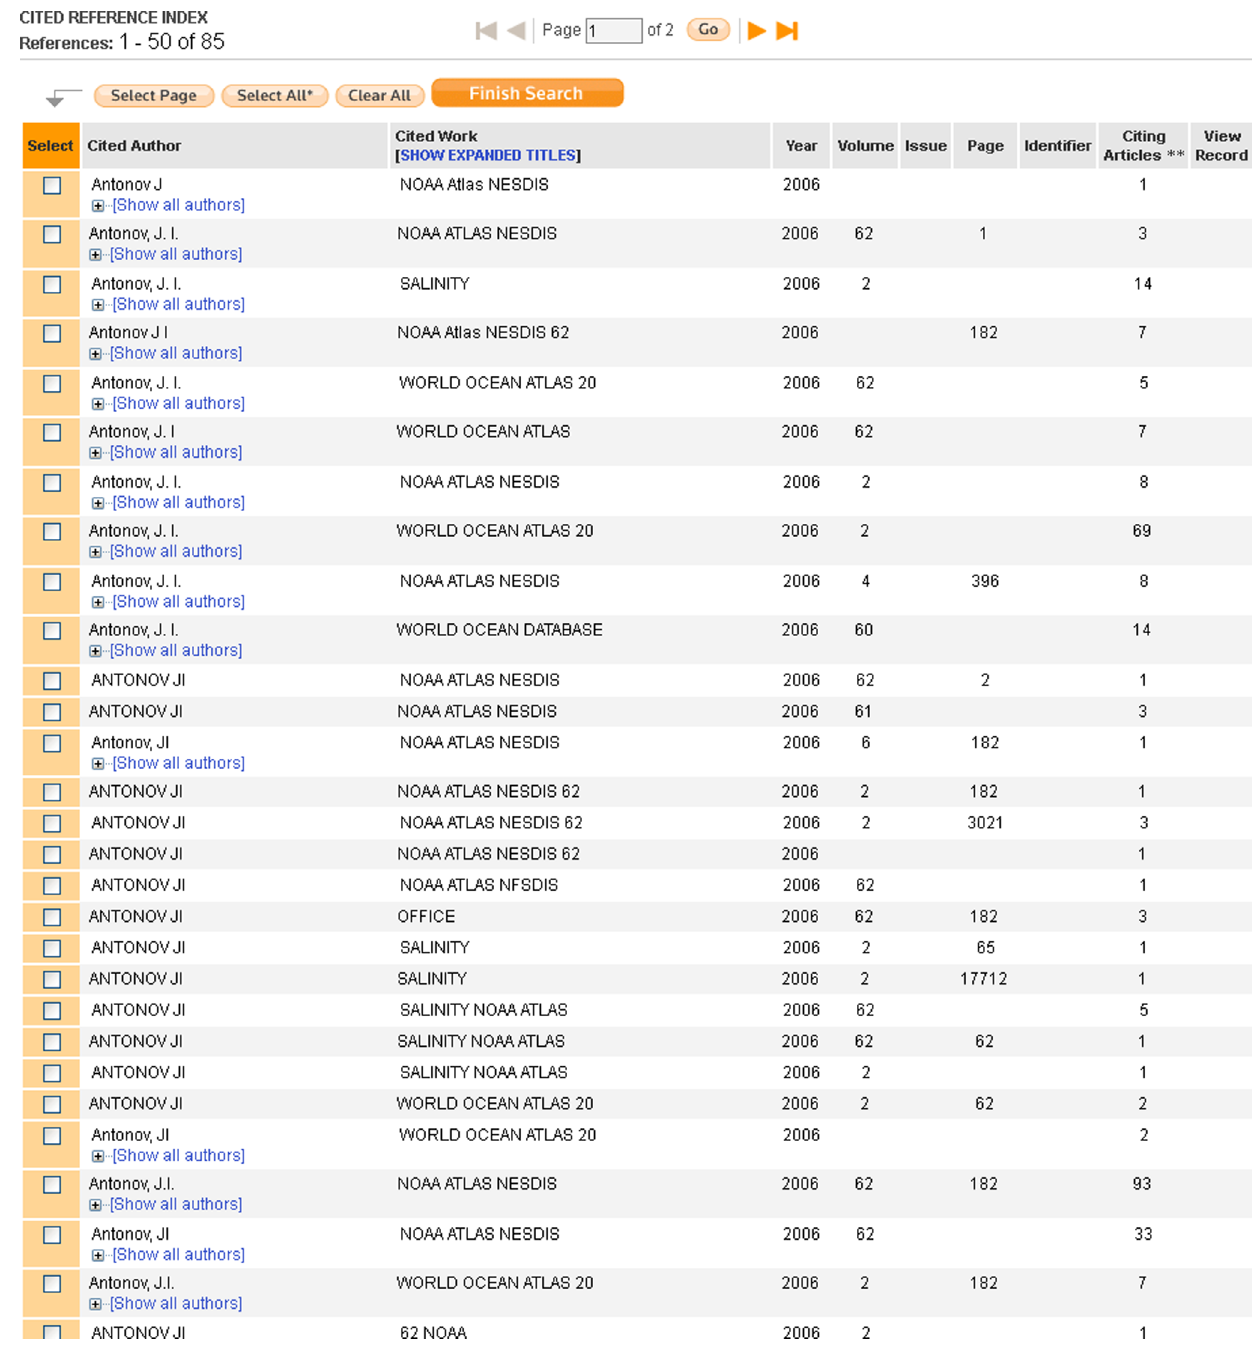
Figure 5. Variant methods of citing the 2005 version of the WOA/WOD in WoS.